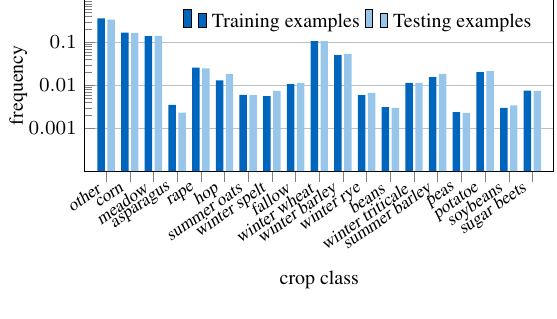
Figure 5. Distribution of classes by fields in the AOI. Common field crops, such as corn or wheat , dominate the dataset with 28k and 22k fields, respectively, while, e.g., asparagus or peas are cultivated in less than 600 fields. Only crops with at least 400 occurances have been included in the